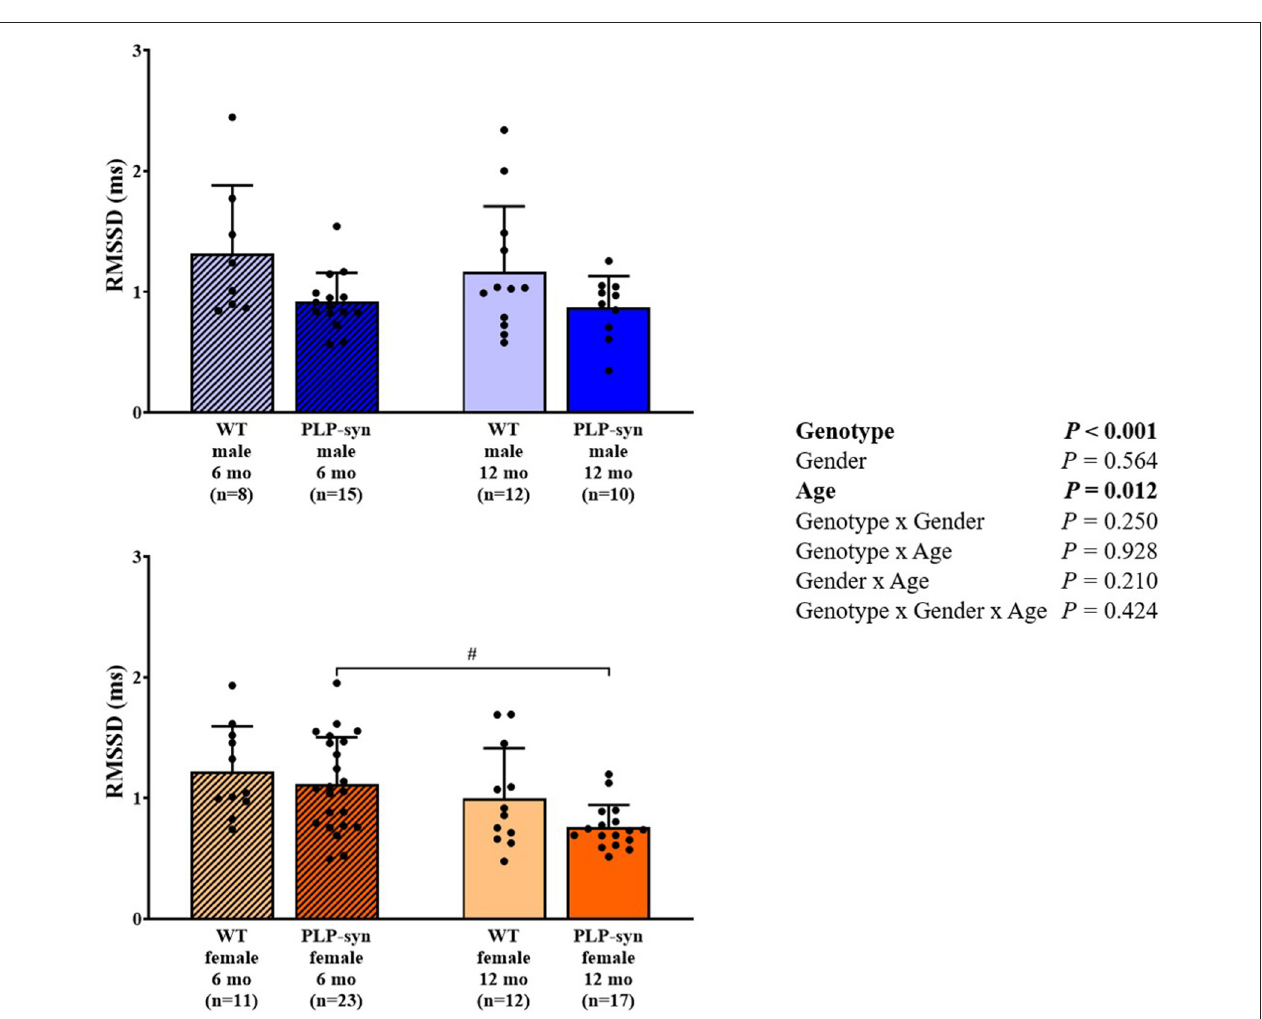
FIGURE 2 | RMSSD in 6 and 12 months, male and female, WT and PLP- α -syn mice. RMSSD, root-mean square differences of successive R-R intervals. # P < 0.05 vs. PLP- α -syn female 6 mo. Black circles represent individual points.